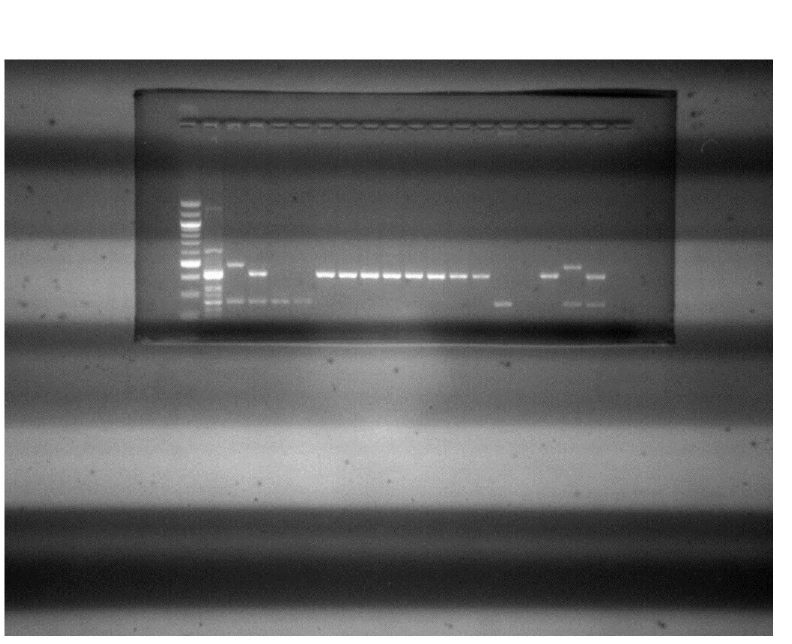
Fig 2. Gel electrophoresis detection of PMQR genes among E . coli and K . pneumoniae isolates. Results by lane: 1- ladder (100bp); 2- ladder (50bp); 3- K . pneumonia qnrB+aac (6’)-lb-cr genes; 4- qnrS + aac (6’)-lb-cr genes; 5,6,15- aac (6’)-lb-cr genes; 7–14- qnrS gene; 16-Undetected.